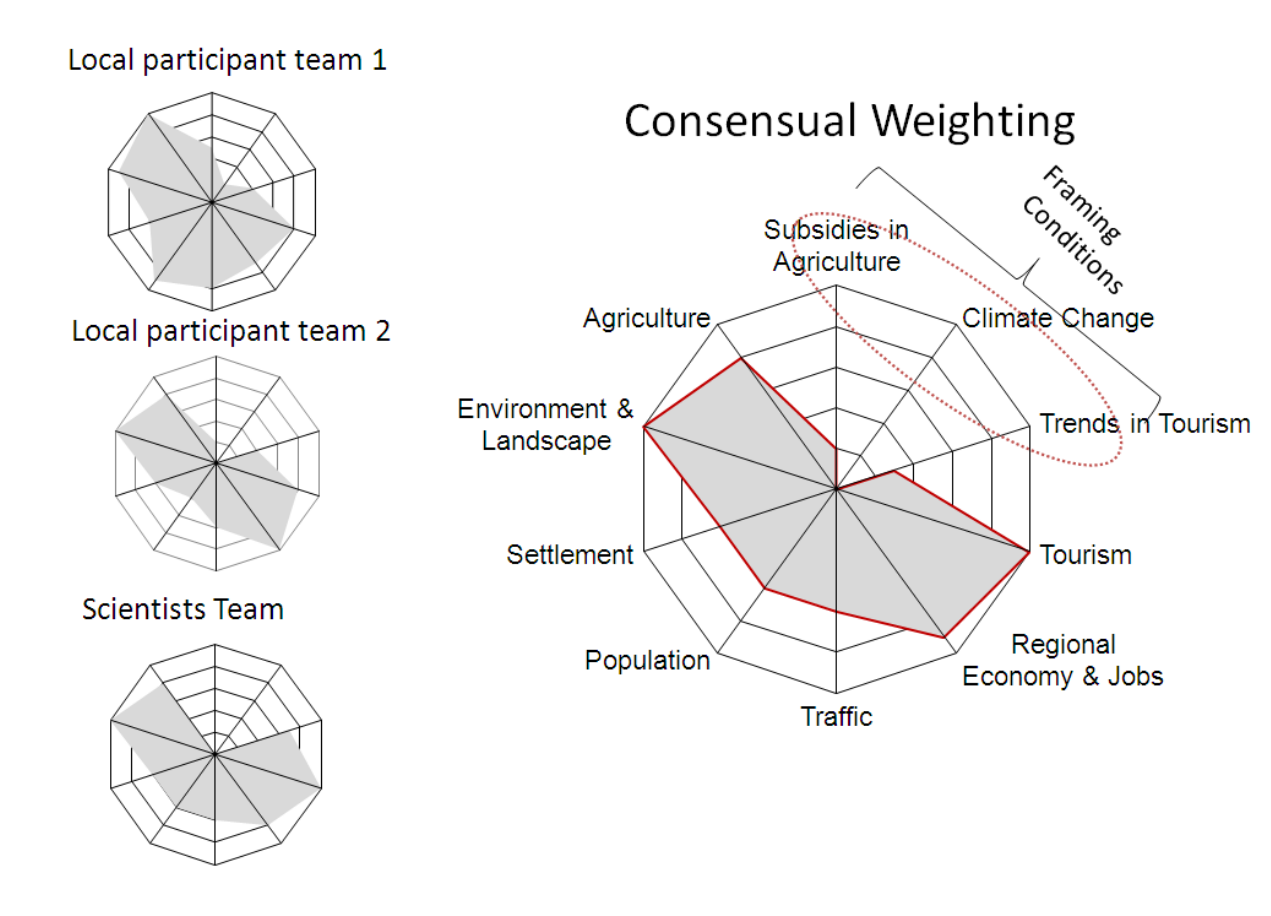
Fig. 4 . Weighting of framing conditions and key elements for future development (Left: weightings of the three teams; right: consensual